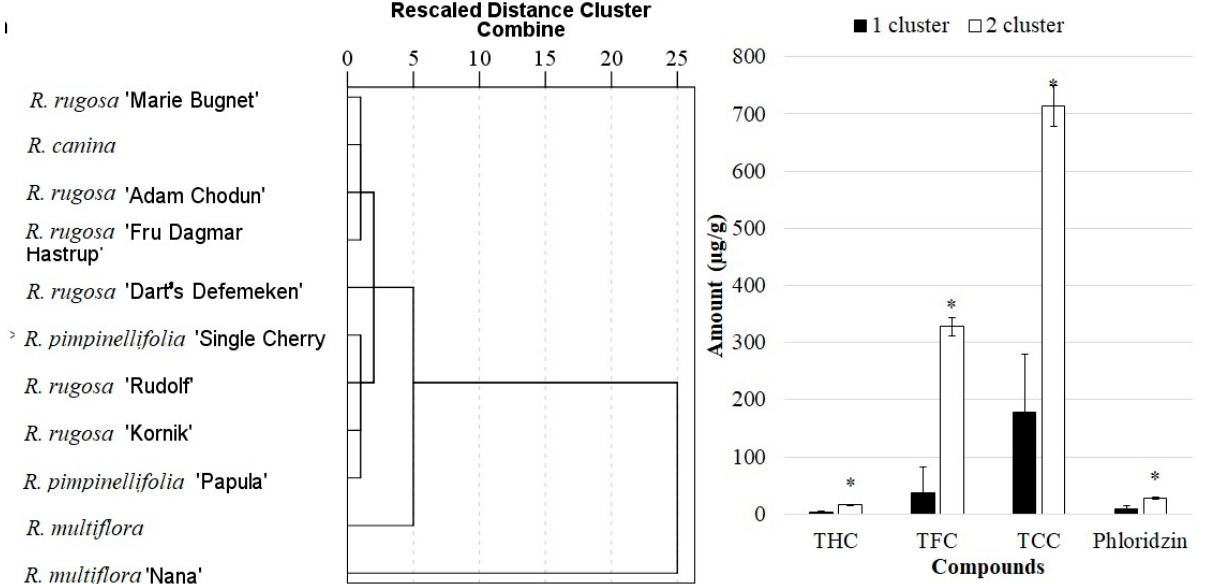
Figure 5. Dendrogram of the similarity of Rosa L. species, based on the composition of phenolic compounds in fruit samples. THC—total content of hydroxycinnamic acid; TCC—total content of flavan-3-ols; TFC—total content of flavonols. * Indicates statistically significant differences in the amounts of phenolic compounds ( p <